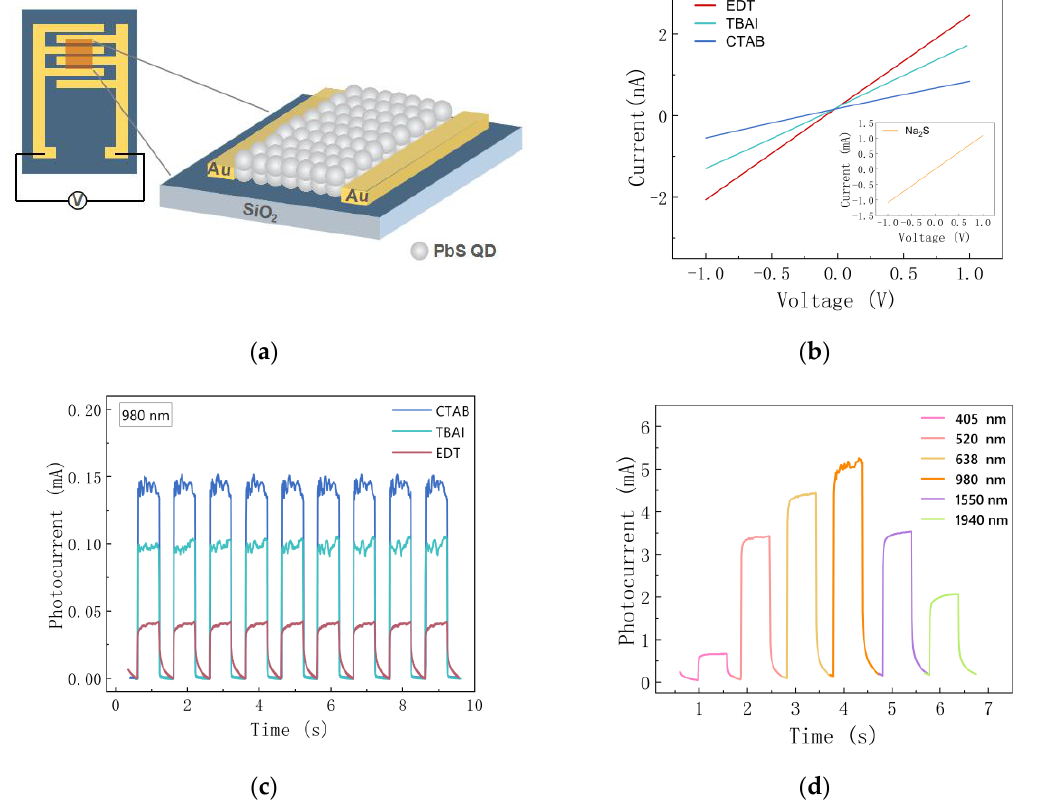
Figure 6. ( a ) Schematic diagram of the PbS QD photodetector structure. ( b ) The current–voltage (I–V) curve of the PbS quantum dot photoconductivity devices obtained in the dark. Insert of the figure shows the I–V curve of the PbS QDs device. ( c ) Photocurrent curves of the PbS-EDT/PbS-TBAI/PbS-CTAB photodetectors at 980 nm. ( d ) Photo response of PbS-Na 2 S photodetectors under incident light of 405 nm, 520 nm, 638 nm, 980 nm, 1550 nm, and 1940 nm (50 mW/cm 2 ) at a bias of 1 V. dot devices treated with the four ligands. For The Na 2 S-treated PbS photodetector, the 95%, demonstrating a broadband photo response (400 – 2300 nm), indicating its suitability for visible and near-infrared light detection. It has been reported that Na 2 S-treated quan- tum dot films show high conductivity and mobility but rapid decay in photoconductivity, while EDT and TBAI show lower conductivity [38], which helps to elucidate the differ- ences between photodetectors treated with Na 2 S and those treated with the other three ligands.